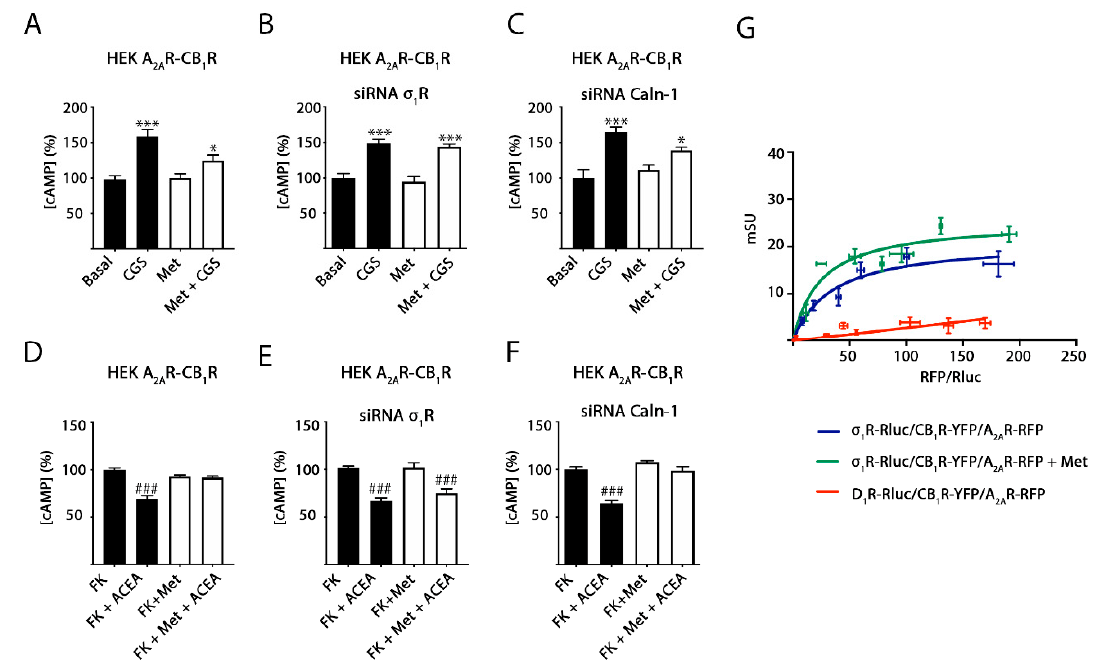
Figure 5. σ 1 R involvement in methamphetamine effects on A 2A –CB 1 Hets. HEK-293T cells were co-transfected with cDNAs coding for A 2A R (0.5 µ g) and for CB 1 R (0.6 µ g) ( A – F ). When indicated, σ 1 R ( B , E ) or calneuron-1 (Caln-1) ( C , F ) were silenced using 3 µ g specific siRNA. Cells were pretreated with 1 µ M methamphetamine (Met, white bars) or vehicle (black bars) for 30 min. GPCRs were activated either using 100 nM of the A 2A R agonist, CGS 21680 in naïve cells (CGS, ( A – C )) or 200 nM of the CB 1 R agonist, ACEA, in cells treated with 0.5 µ M of forskolin (FK) ( D – F ). Then, cAMP levels ( A – F ) were determined and expressed as a percentage over basal (A 2A R) or forskolin (CB 1 R). Values are the mean ± SEM of five different experiments performed in triplicates. One-way ANOVA followed by Bonferroni multiple comparison post hoc test showed significant effects (* p < 0.05, *** p < 0.001 vs. basal condition or ### p < 0.001 vs. FK condition). In G , SRET experiments were performed in HEK-293T cells transfected with constant amounts of cDNAs for σ 1 R-Rluc (0.5 μ g) or D 1 R-Rluc (0.33 μ g) and for CB 1 R-YFP (1 μ g) and increasing amounts of cDNA for A 2A R-RFP (0.25 μ g to 2.5 μ g). Results were grouped by amount of SRET acceptor.